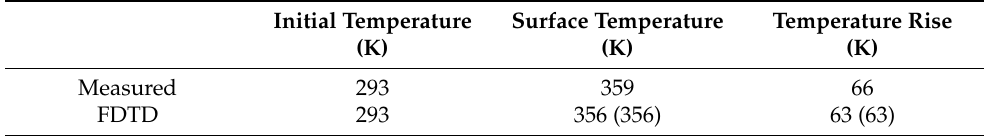
Values in parentheses are calculated without the temperature